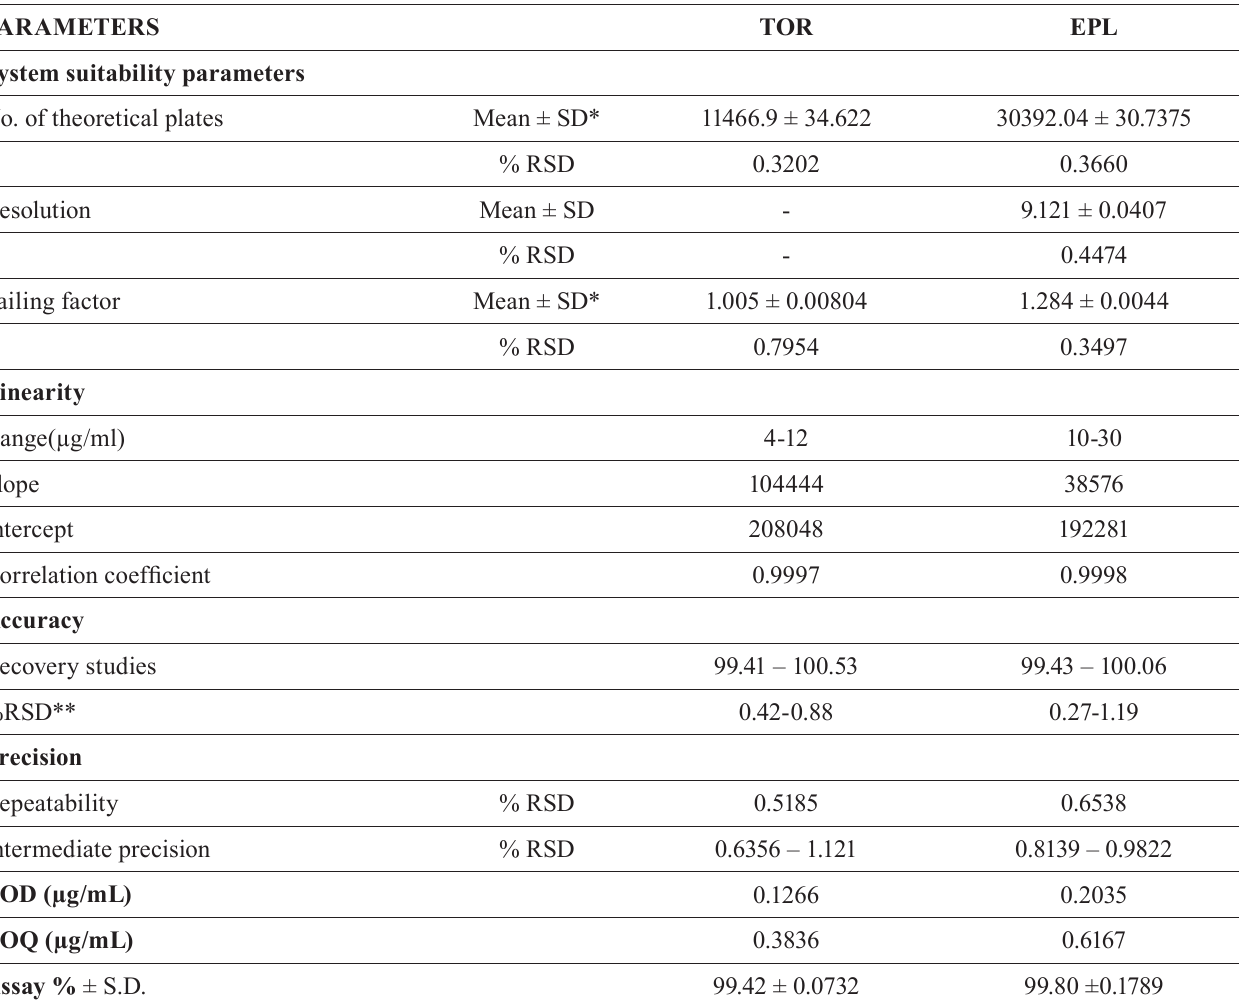
TABLE V - V alidation results for TOR and EPL PARAMETERS TOR System suitability